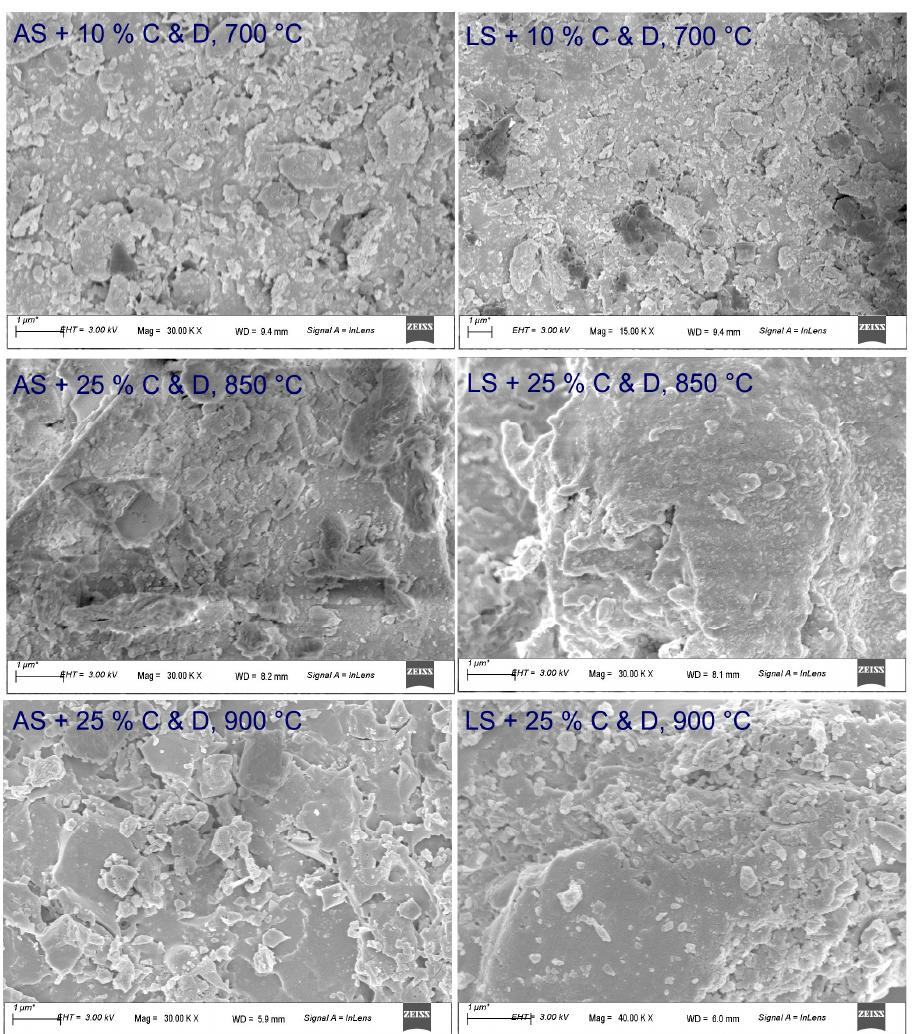
Figure 12. SEM images of the optimal mixtures of alluvial soil (AS) and laterite soil (LS) with construction and demolition waste (C&D) (10% C & D at 700 ⁰ C and 25% C & D at 850 ⁰ C and 900 ⁰ C).